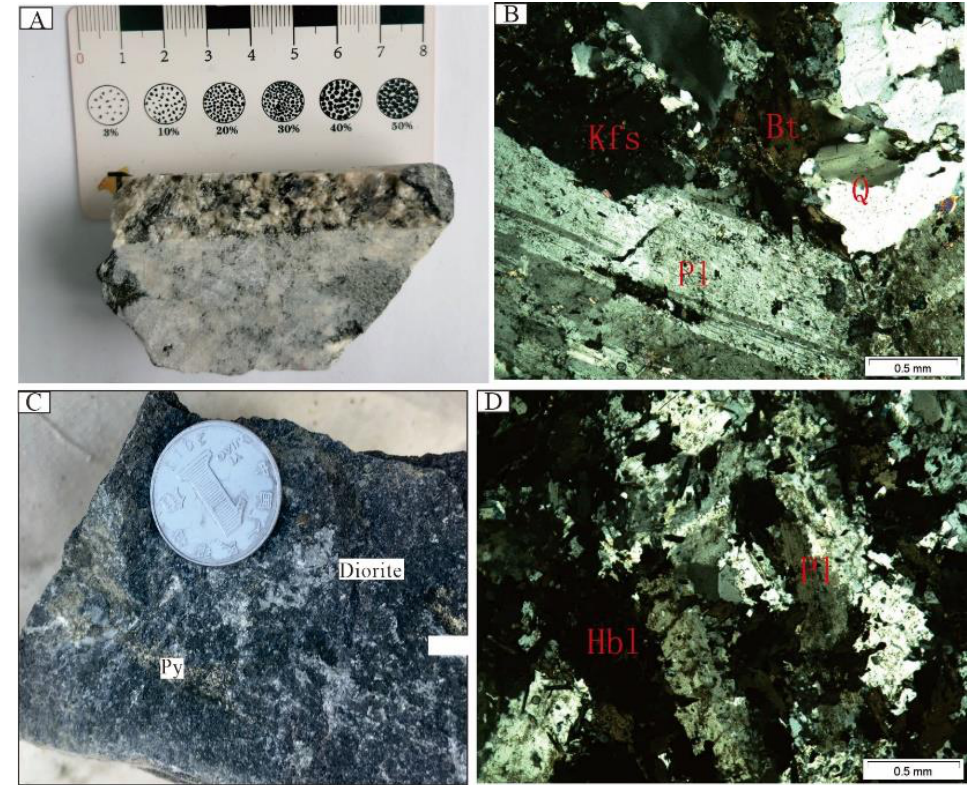
Figure 3. Hand specimen and photomicrographs of rocks from Jinba gold deposit. ( A ) — Granite dyke hand specimen, ( B ) — Photomicrograph of the granite dyke, ( C ) — Diorite dyke hand specimen, ( D ) — Photomicrograph of the diorite dyke. Q — quartz; Pl — plagioclase; Kfs — K-feldspar; Hbl — hornblende; Bt — biotite.